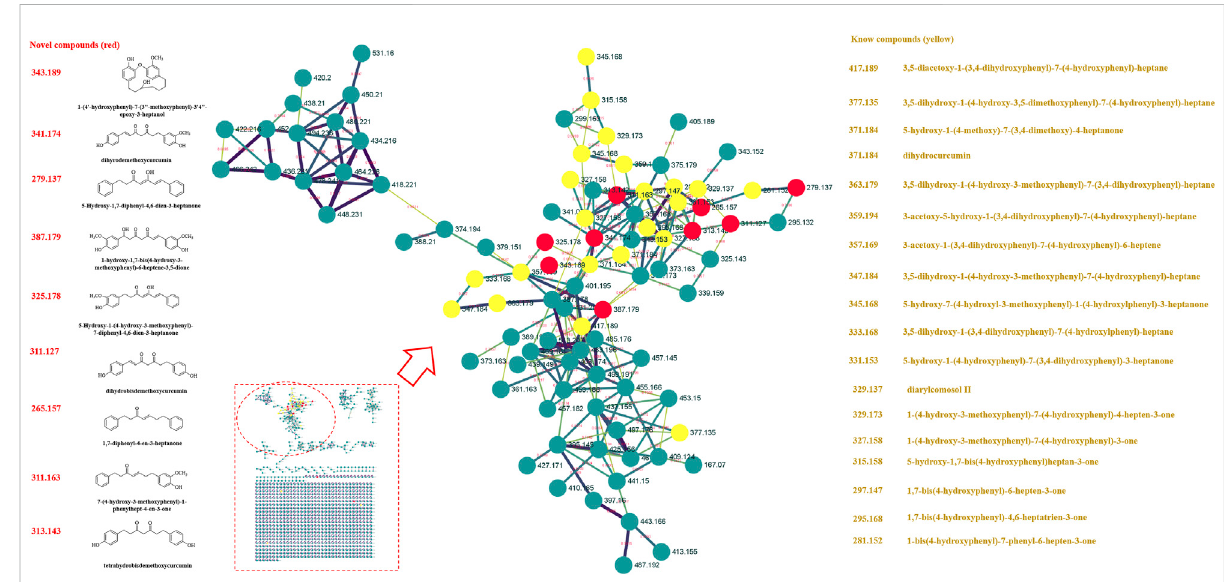
The total ion chromatograms (TIC) of CR-SR, CR, and SR in positive and negative ion modes are presented in Figure 4 and Figure 5. The detailed information and structures of the identi fi ed components are shown in Table 3 and Figure